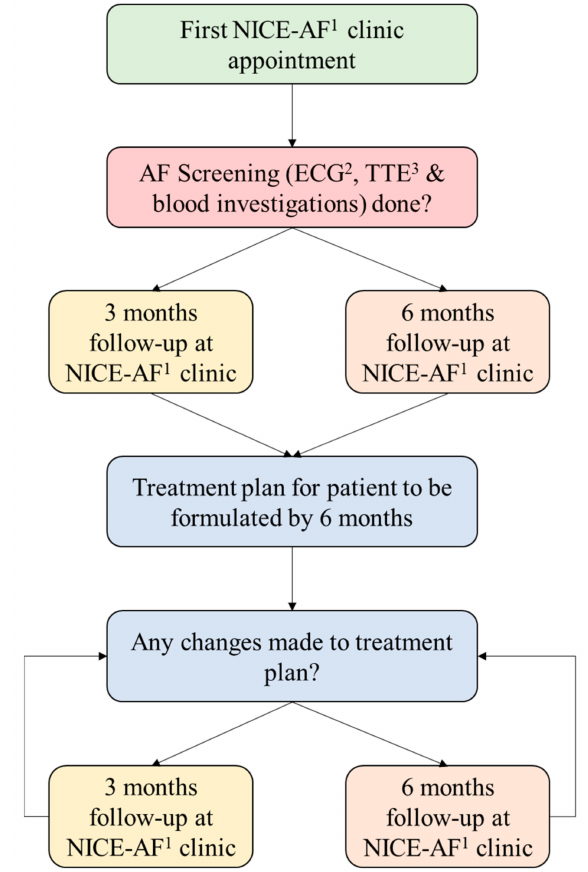
Figure 3. Frequency of clinic visits. 1 Nurse-led Integrated Chronic care E-enhanced Atrial Fibrillation clinic; 2 electrocardiogram; 3 transthoracic echocardiogram.